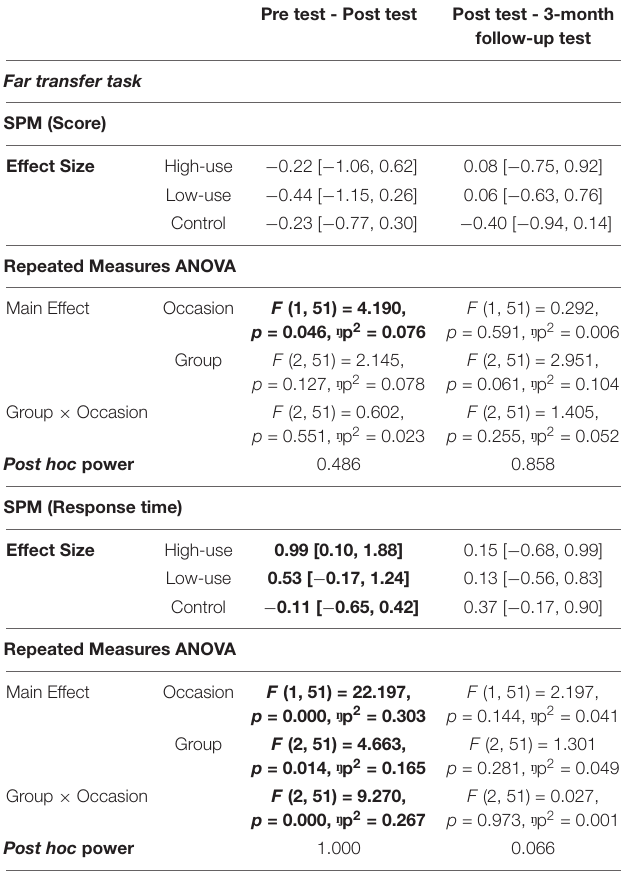
Table 10 . Group × occasion interactions and main effects